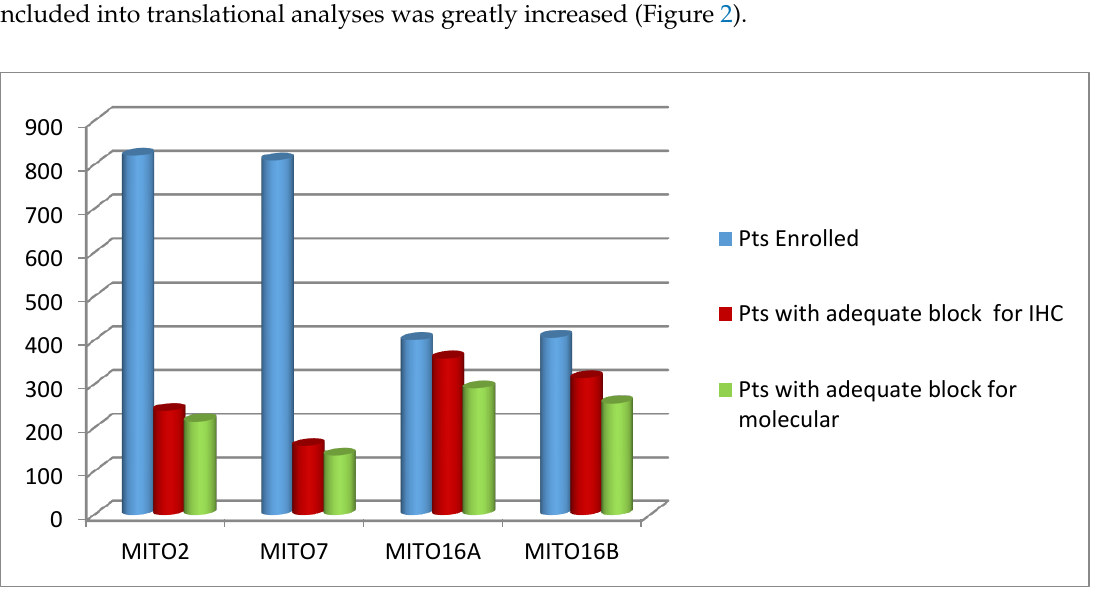
Figure 2. Number of patients (Pts) enrolled in the four clinical trials, with FFPE blocks Figure2. Numberofpatients(Pts)enrolledinthefourclinicaltrials, withFFPEblocksavailable / adequate available/adequate for the indicated purposes. Block collection was retrospective for MITO2 and for the indicated purposes. Block collection was retrospective for MITO2 and MITO7, and prospective for MITO16A / MITO7, and prospective for MITO16A/B.